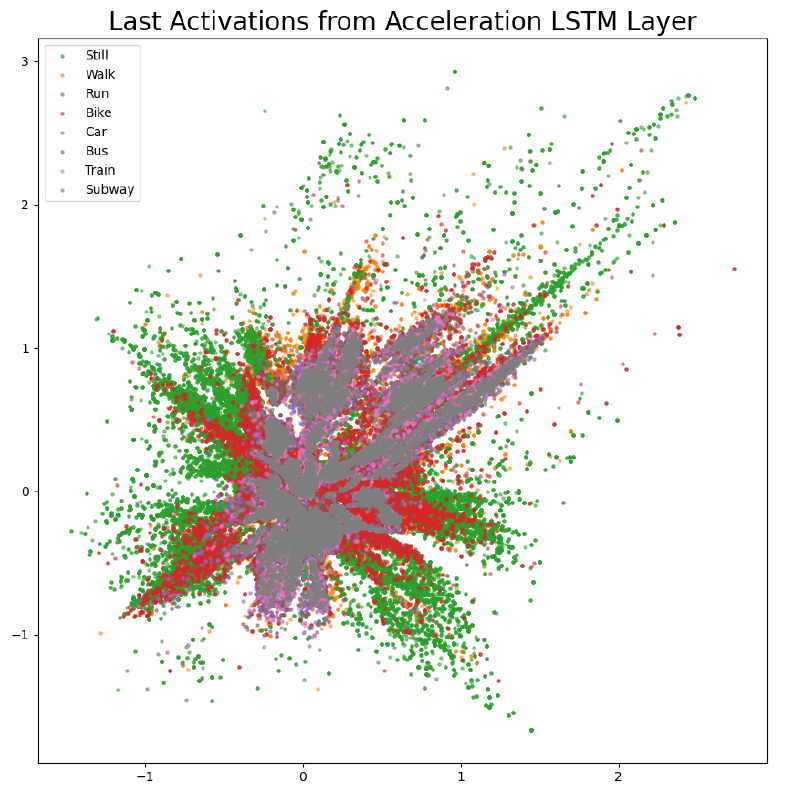
Figure 9. The 2D encoded representation of the last activations of the LSTM layer for the acceleration sensor. Color codes: blue (still), orange (walk), green (run), red (bike), violet (car), brown, (bus), pink (train), grey